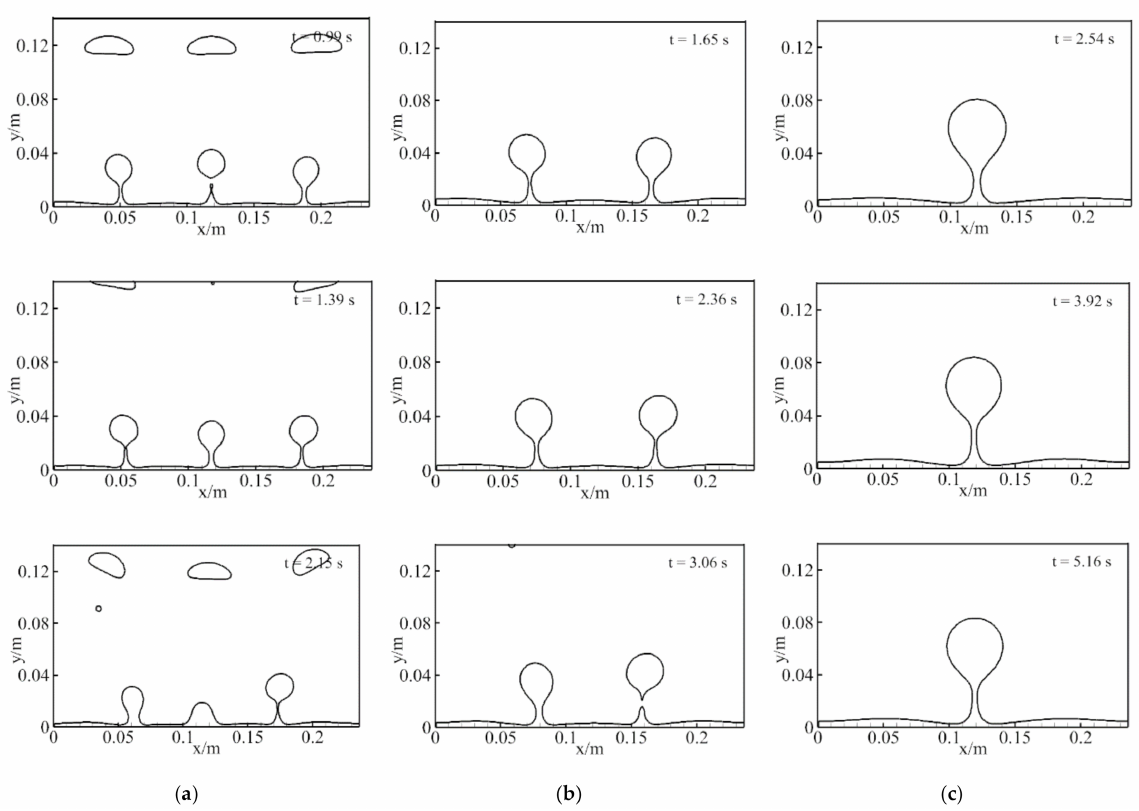
Figure 11. The bubble detachment at different gravity levels when H 0 = 10 kA/m. ( a ) g / g e = 1.0, ( b ) g / g e = 0.44, and ( c ) g / g e =